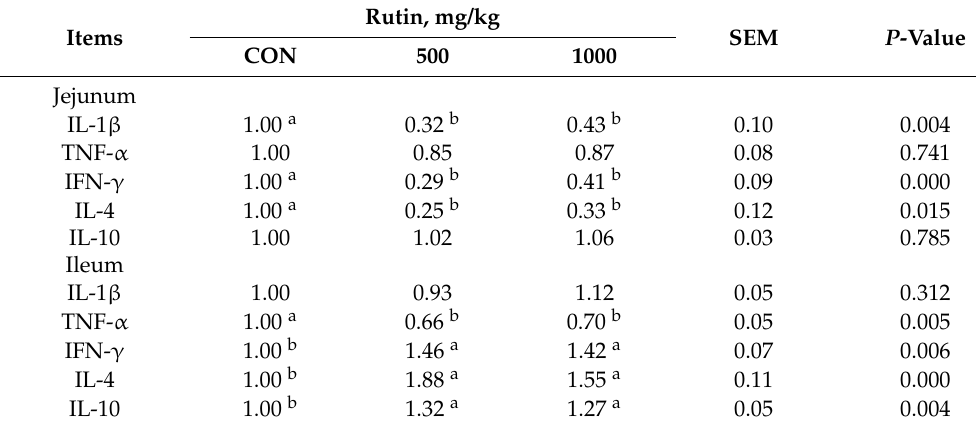
Table 8. Effects of rutin supplementation on the relative mRNA abundances of the intestinal cytokines of aged laying